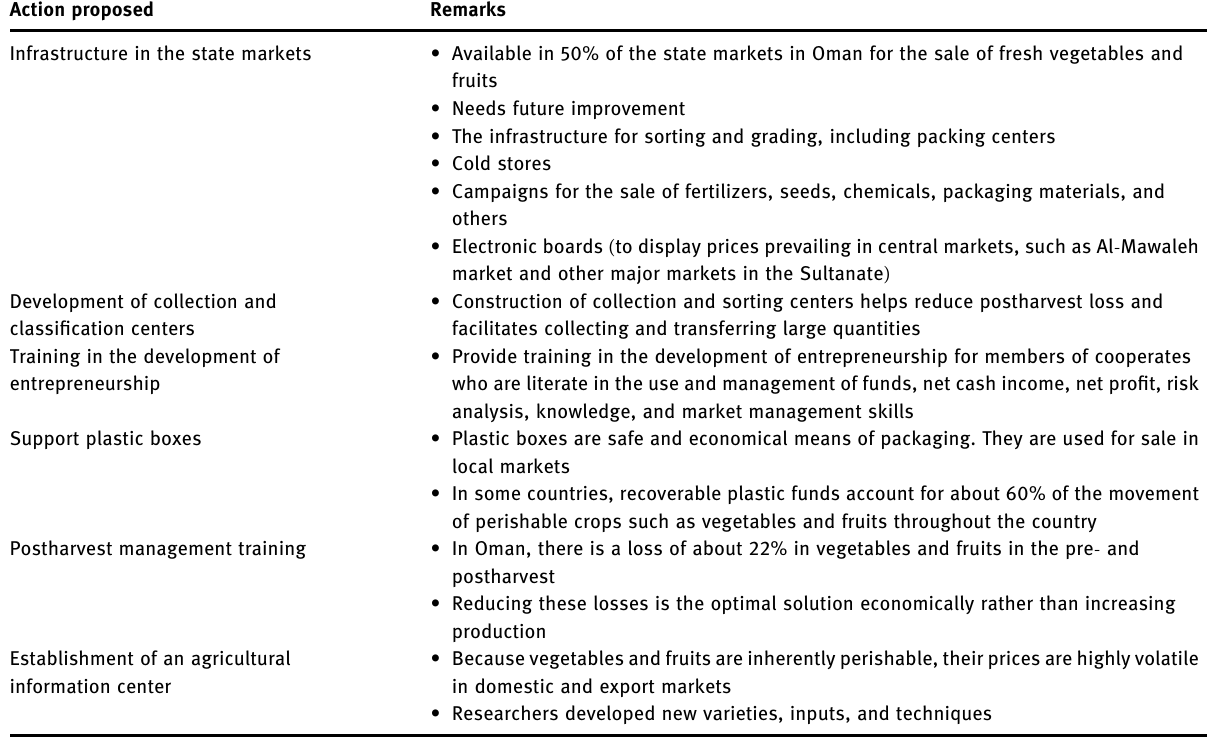
Table 7: The proposed actions to strengthen the supply chain of vegetables and fruits [ 52 ]